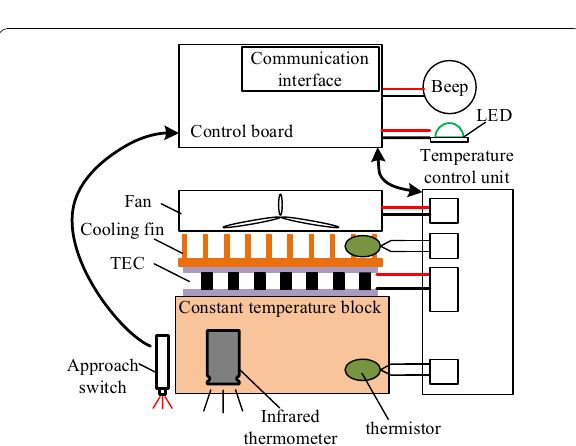
Figure 4 Structure of the high‑accuracy thermometer